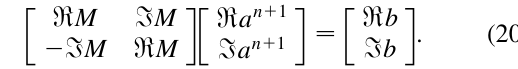
FIG. 3. Envelope phase during propagation through the focus for transverse resolutions of the laser pulse of w (cid:3) 2(cid:1) y (dotted). The Gouy phase shift is 45 (cid:11) . and w 0